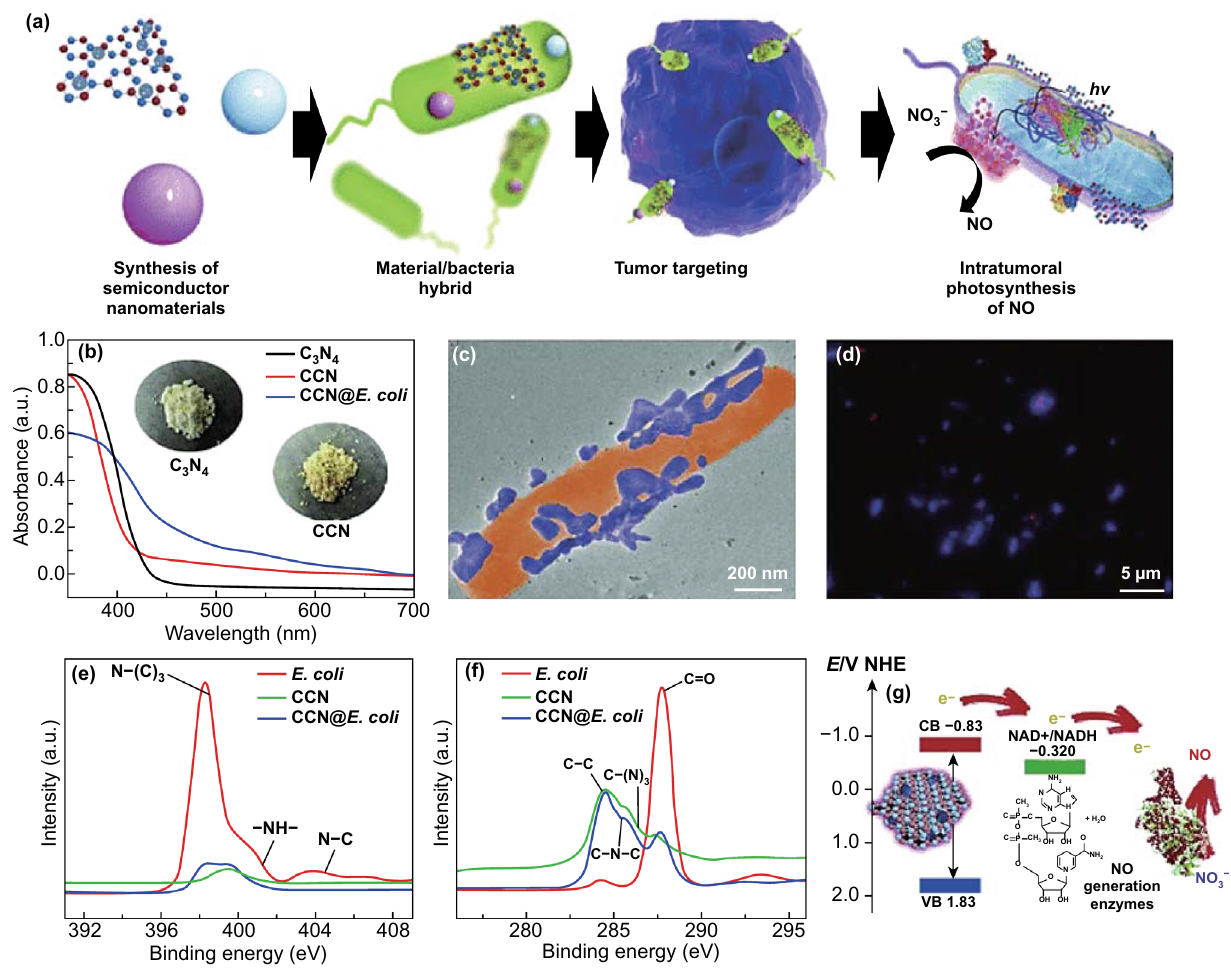
Fig. 4 Characterization of a bacteria-mediated reactive nitrogen species therapy system. a Schematic of CCN@ E. coli for photo-controlled bacterial metabolite anticancer treatment. First, carbon-dot-doped carbon nitride (CCN) with suppressed free radical generation capability was synthesize. Furthermore, CCN and E. coli MG1655 ( E. coli ) were assembled through electrostatic interactions to obtain CCN@ E. coli . Then, CCN@ E. coli can be targeted to the tumor site and metabolize NO 3− to antitumor NO under photo-irradiation. b UV–Vis absorption spectra of the CCN. c TEM image of CCN@ E. coli . d Spinning disk confocal microscope image of CCN@ E. coli (Red: E. coli , Blue: CCN). e XPS de- convoluted spectra for the N1s orbitals of E. coli , CCN, and CCN@ E. coli . f XPS de-convoluted spectra for the C1s orbitals of E. coli , CCN and CCN@ E. coli . g Schematic illustration for the photoelectron transport among CCN, electron acceptor and NO generation enzymes. Reprinted with permission from Ref.